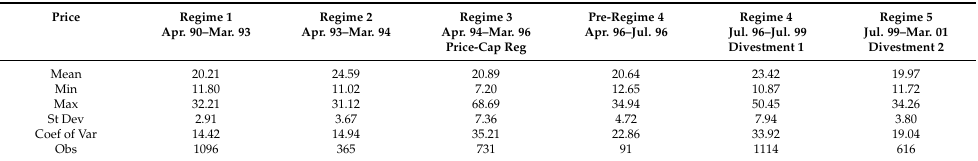
Table 1. Summary statistics of demand weighted average electricity price over days